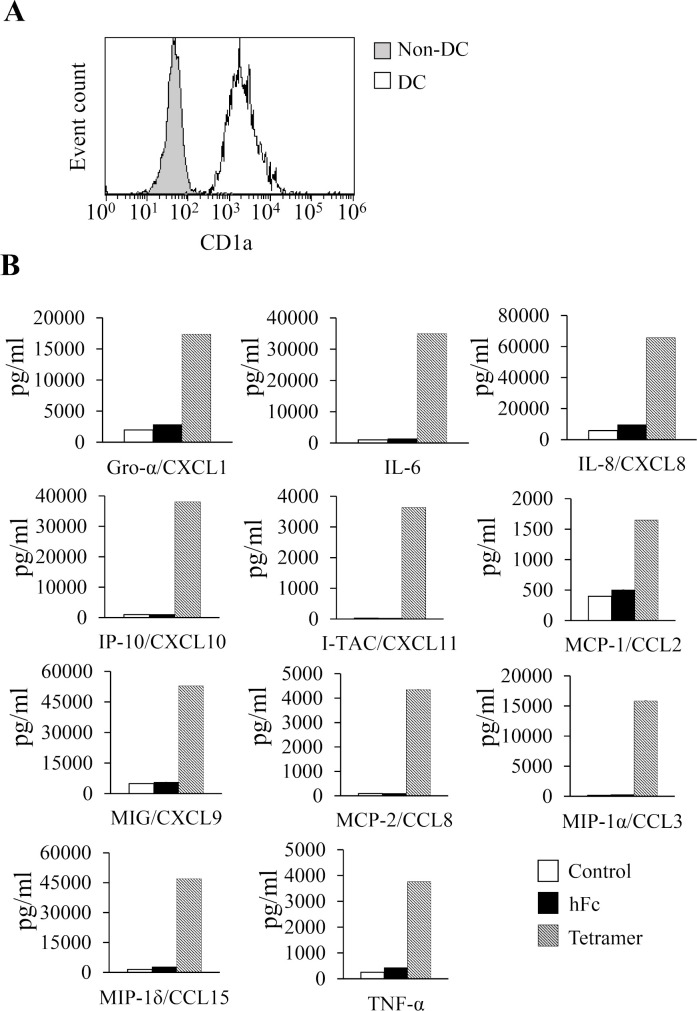
Human cytokine/chemokine levels in the culture supernatant of DCs treated with HHV-6B tetramer.(A) Detection of the marker of immature DC, CD1a, by flow cytometry to attest the prepared human monocyte derived DCs. (B) The secretions of cytokines/chemokines by human monocyte-derived DCs 24 hr after they were stimulated with culture medium (control), hFc, or tetramer were measured by a Bio-Plex system. The cytokines/chemokines that showed higher responses to the stimulation by the tetramer compared to the control and hFc are shown. Consistent results using cells from two donors were obtained, and the representative data of one volunteer are shown as the mean of duplicate measurements.